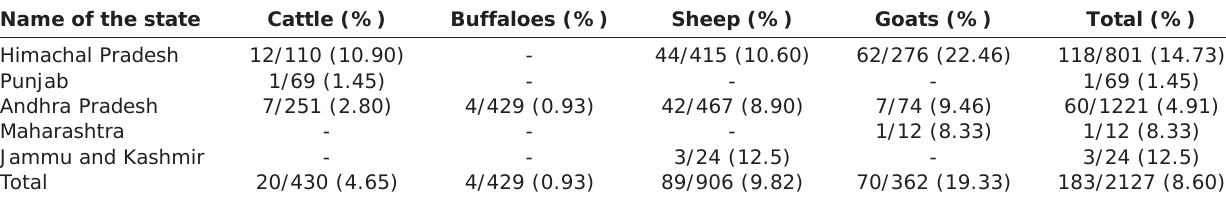
Table 2: Seroprevalence of chlamydial infections amongst ruminants Name of the state Cattle